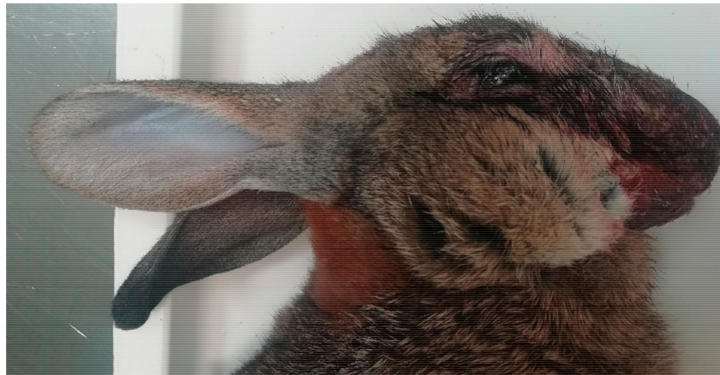
Figure 1. Mild oedema of the eyelid and presence of serous discharge (Male).